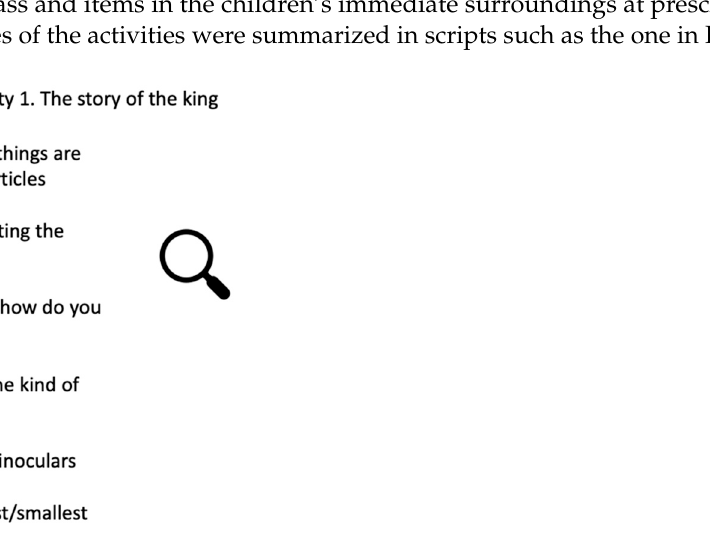
Figure 1. The general outline of activity 1, which included the story of the king and his birthday.